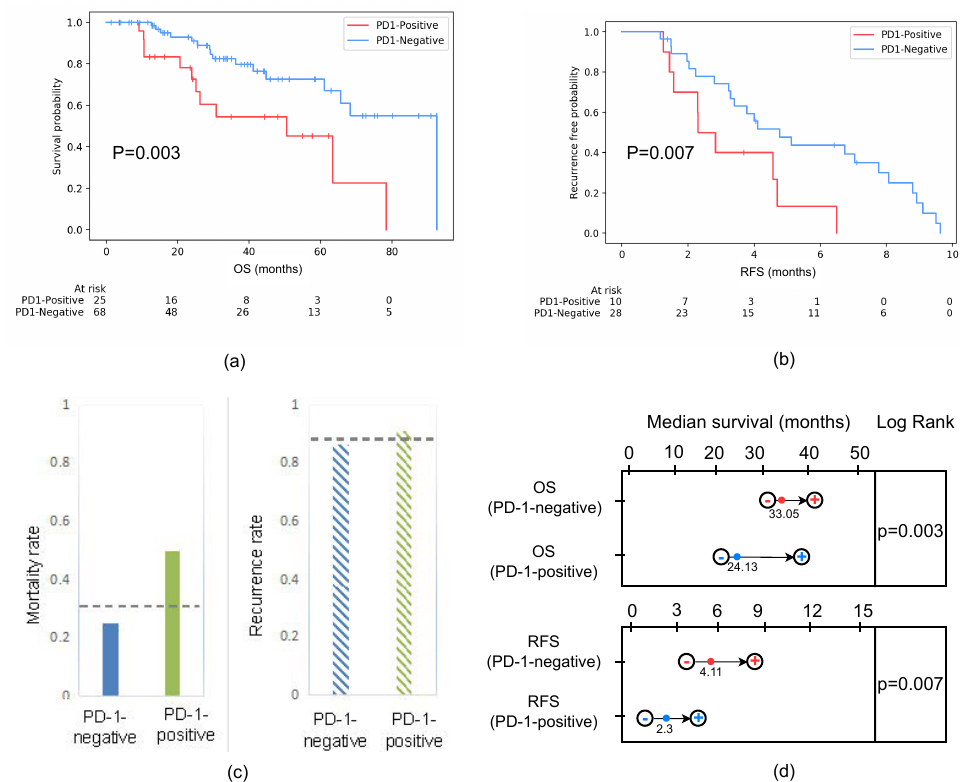
Figure 7. ( a ) Survival curves according to the predicted PD-1 status in all patients, including training and testing cohorts. The OS of PD-1-negative was better than that of PD-1-positive. Statistically, p = 0.003 < 0.05 represents a significant difference between the survival curves of the PD-1-negative and PD-1-positive groups. ( b ) RFS curves scaled by the predicted PD-1 status in the follow-up period within one year. The RFS of the PD-1-negative group was better than that of the PD-1-positive group. Statistically, p = 0.007 < 0.05 represents a significant difference between the survival curves of the PD-1-negative and PD-1-positive groups. ( c ) Mortality and recurrence rates based on the predicted PD-1 among patients. The mortality rate of patients that were PD-1-negative was 0.235, while the PD-1-positive rate was 0.48. The recurrence rate of patients that were PD-1-negative was 0.862, while the PD-1-positive rate was 0.909. The gray dotted line represented the mortality rate (0.324) and recurrence rate (0.875) of all patients regardless of whether the patient was PD-1-positive or PD-1-negative. ( d ) Survival time estimation based on 95% CI. The median OSs of the PD-1-negative and PD-1-positive groups were 33.05 (95 (CI): 31.56–42.87) and 24.13 (95 (CI): 22.75–39.31)